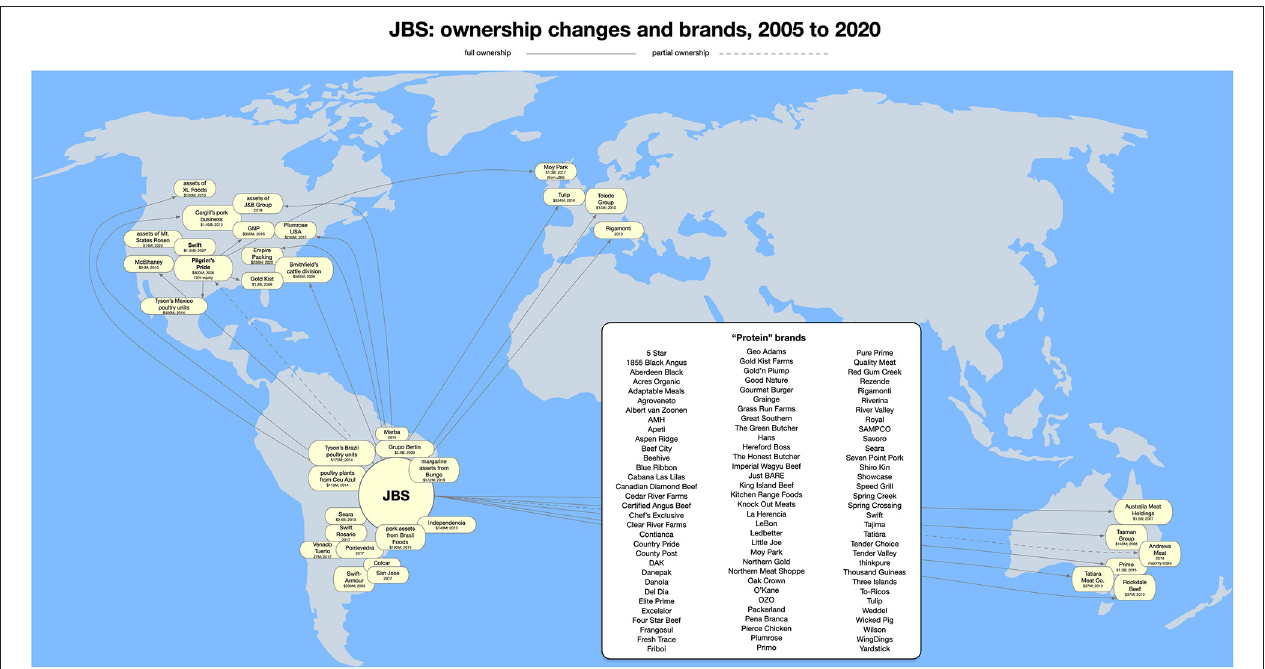
FIGURE 6 | Map of JBS ownership changes and brands,